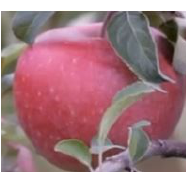
Figure 7. Second apple identified in the second frame, noted as detection 2 is tested for